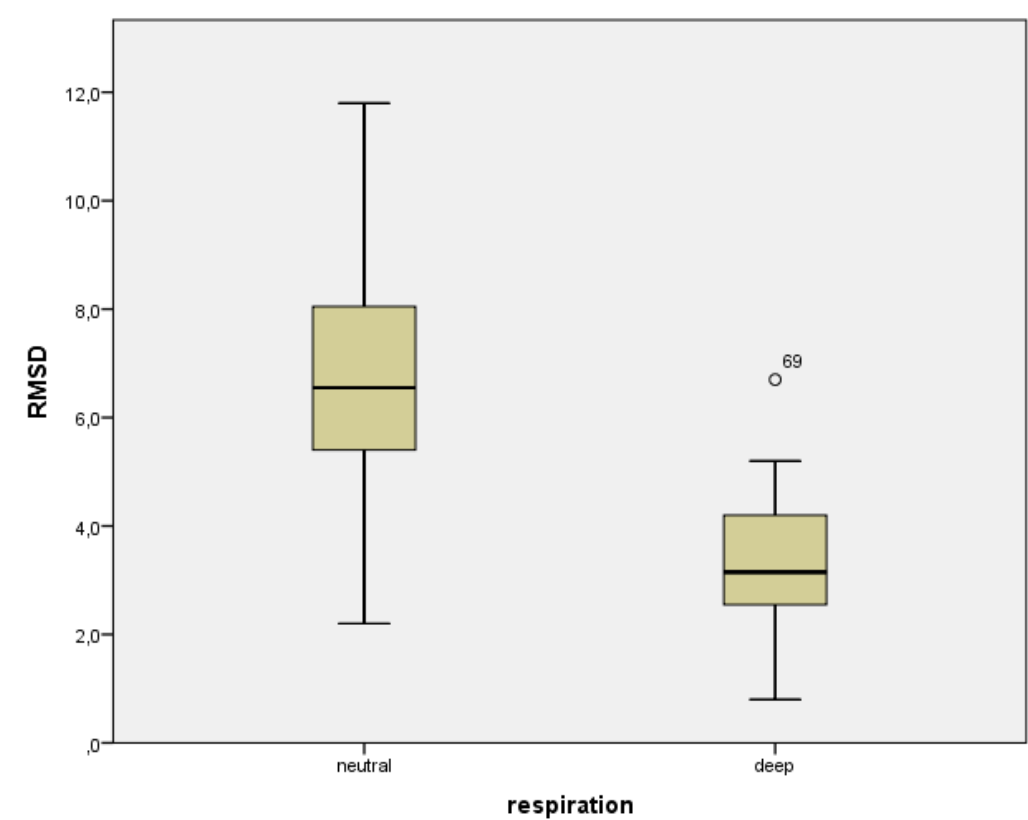
Figure 3. Box-whiskers plot showing distribution of accuracies for deep and neutral respiration, when arms were above the